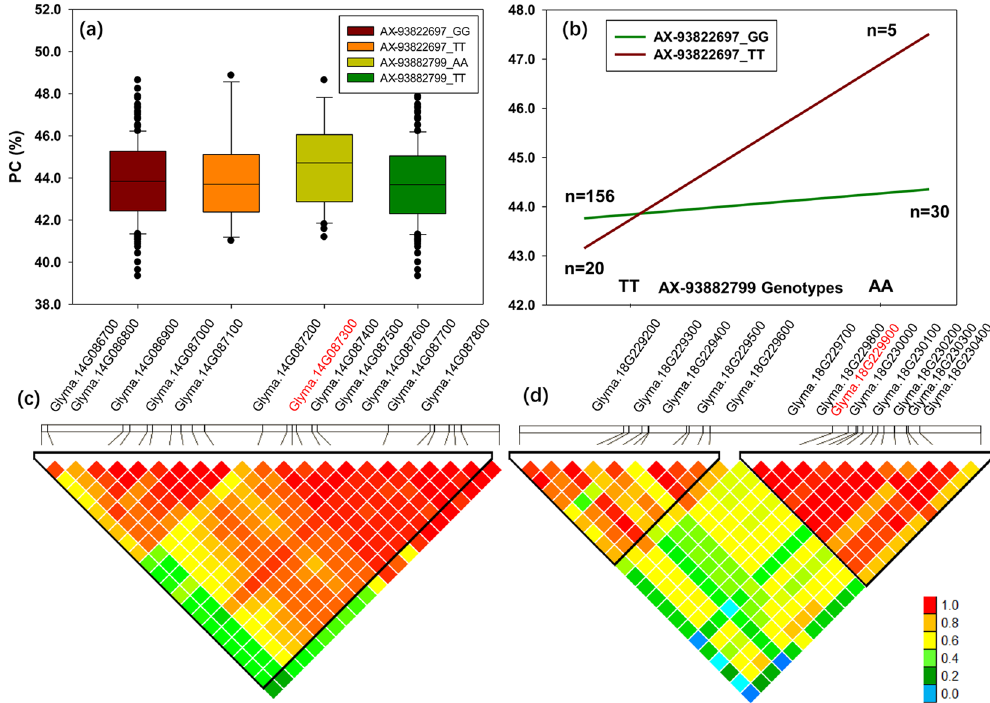
Figure 4. Epistatic interaction between AX-93822697_T_A and AX-93952504 _G_T associated with PC, and candidate gene for each SNP locus. ( a ) Box plot of PC based on different genotypes in soybean accessions. ( b ) Phenotypic differences between genotype combinations of the two SNP. ( c ) and ( d ) Candidate genes for AX- 93822697_T_A and AX-93952504 _G_T loci, respectively. The proposed causal genes are indicated in red. The bottom panel depicts the extent of linkage disequilibrium in the regions based on pairwise r 2 values. The r 2 values are indicated using the color intensity index shown.